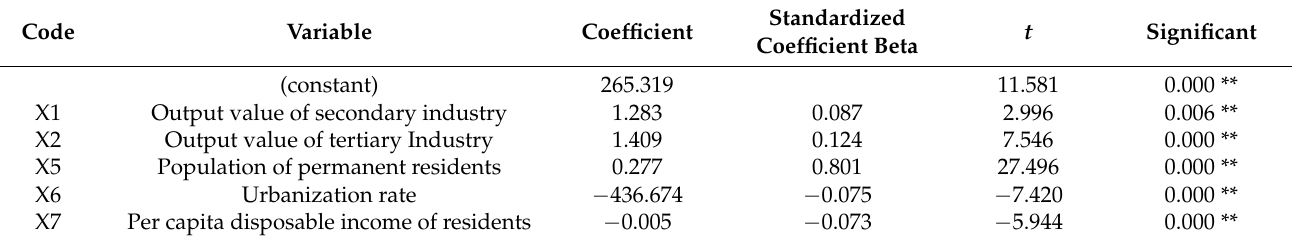
Table 5. Estimation results of the driving factors in the TWL region using stepwise regression (2010–2019).